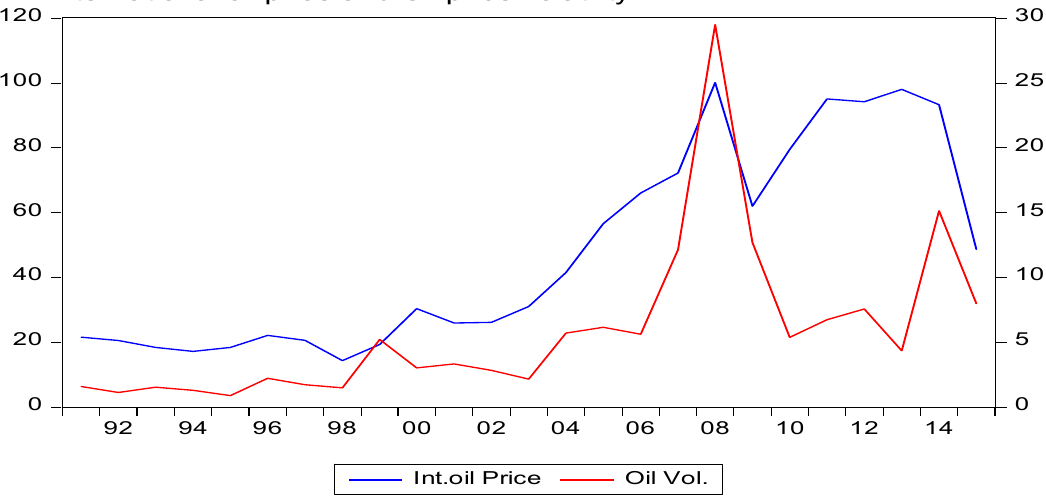
Figure 1. International oil price and oil price volatility. Source: Authors’ calculation using annexed data sources.